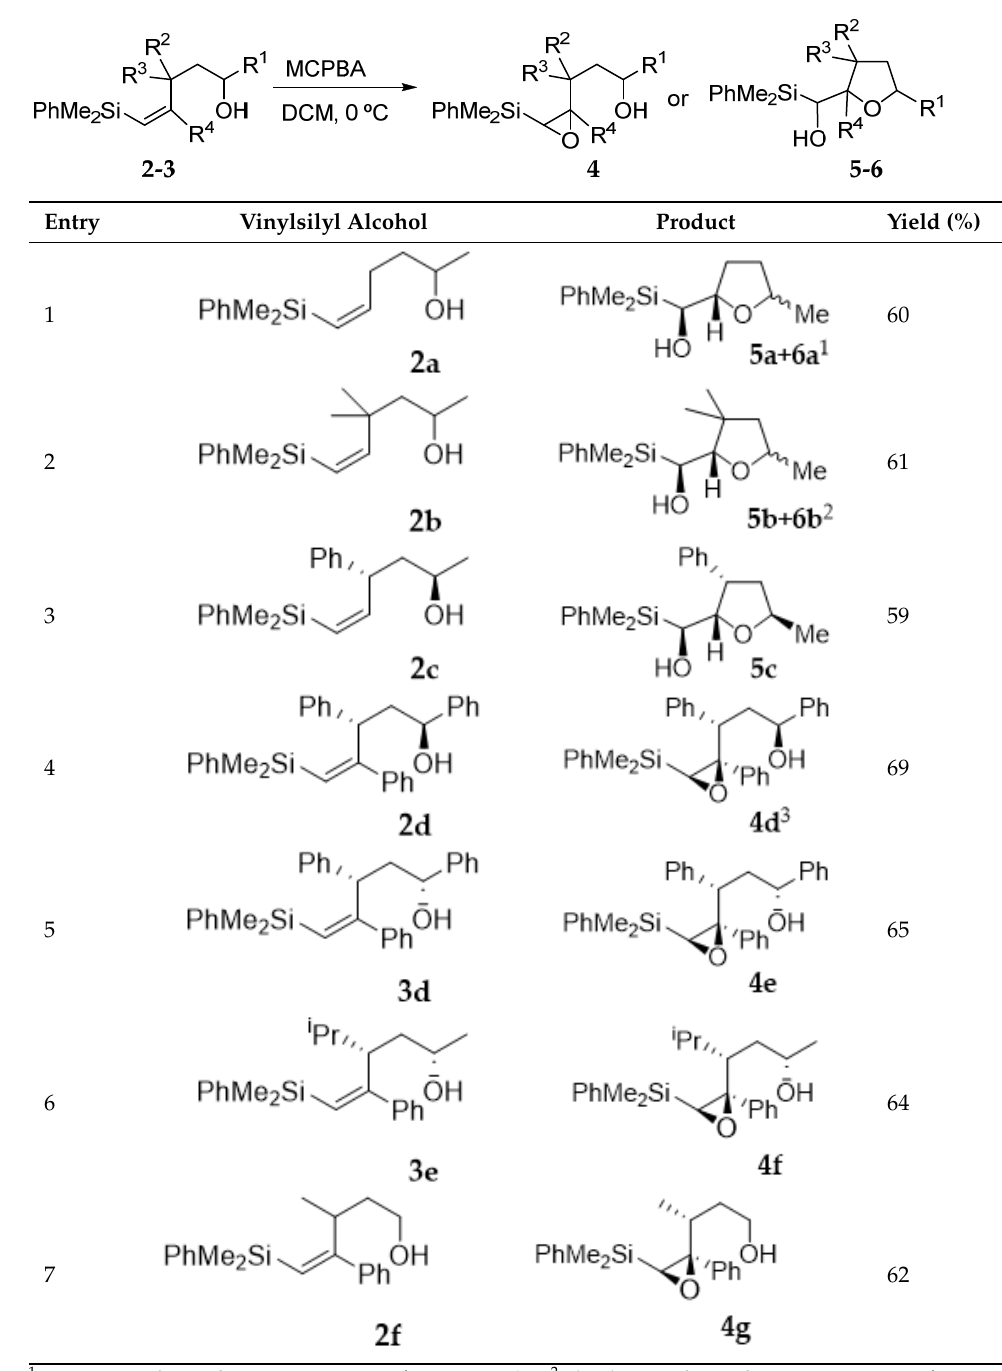
Table 1. Reaction of vinylsilyl alcohols 2-3 with MCPBA.